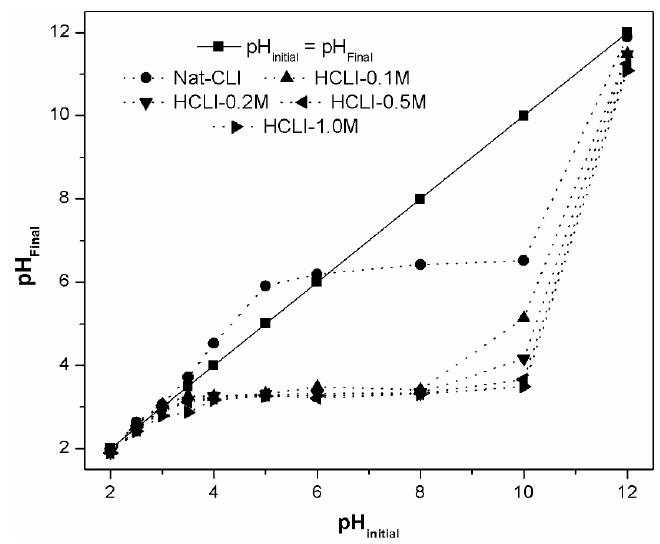
Figure 4. pH initial vs. pH final of non- and acid-modified clinoptilolite-rich tuffs.